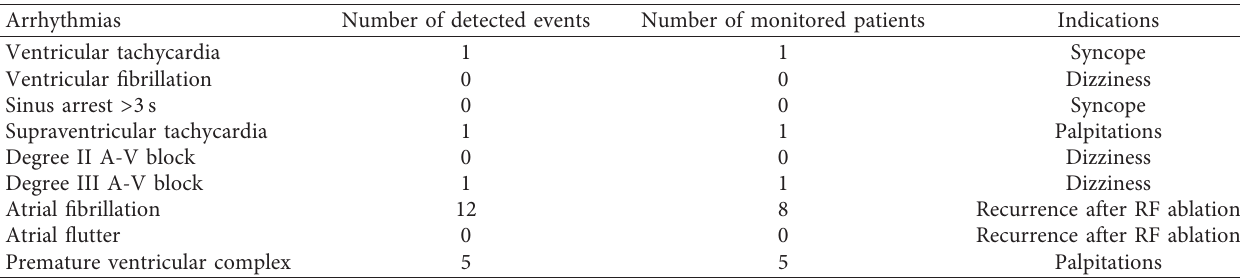
Table 3: Arrhythmias detected by the Spyder device.